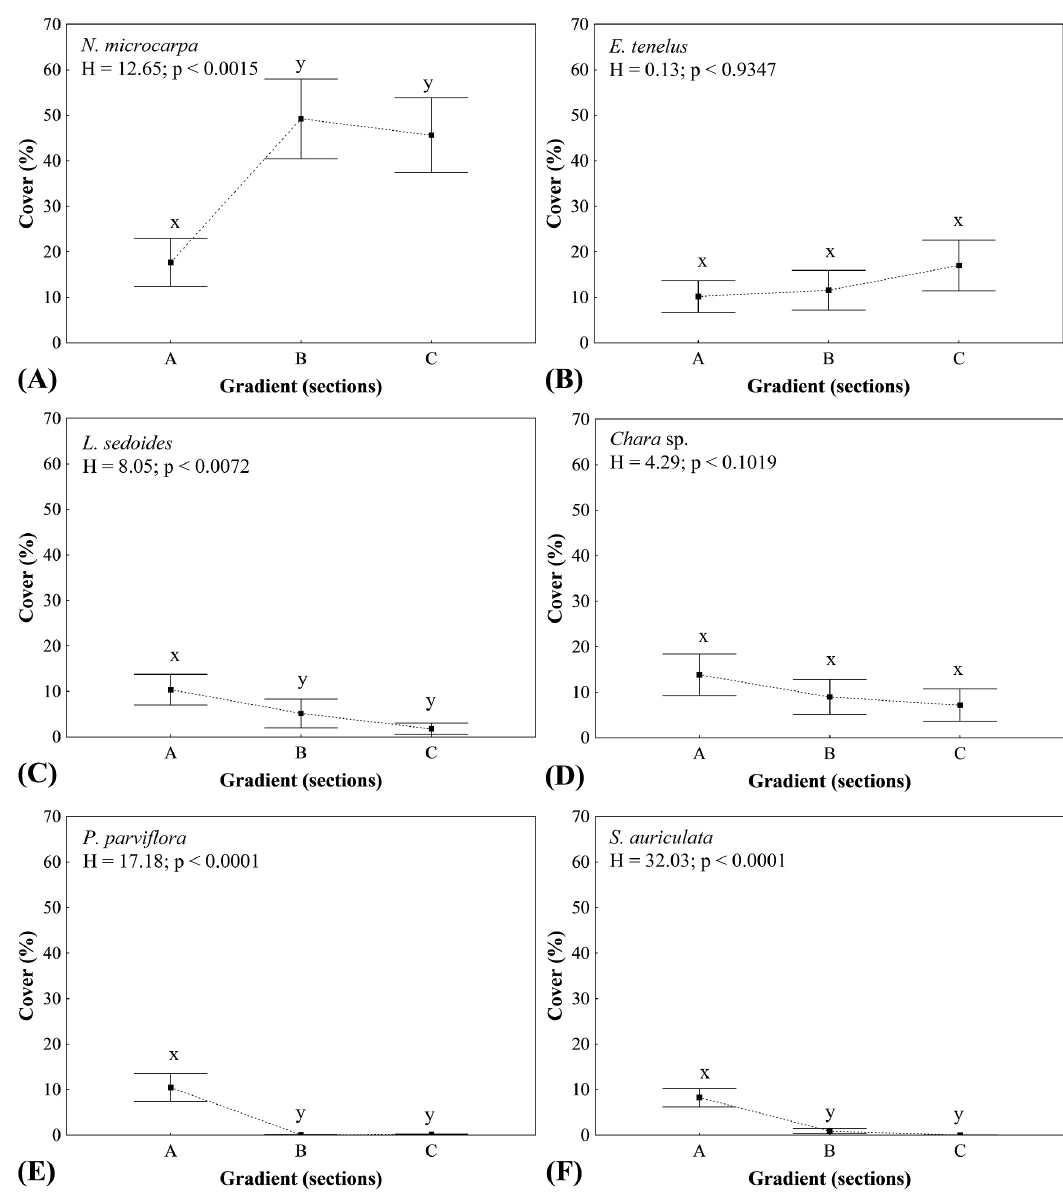
Figure 6. Variation in the abundance (% cover) of main species (A-F) along the depth gradient (sections A, B and C). Dots are mean values and bars represent the standard error. Statistical differences among sections were tested with non-parametric ANOVA (Kruskal-Wallis, H) and Mann-Whitney pairwise comparison (different